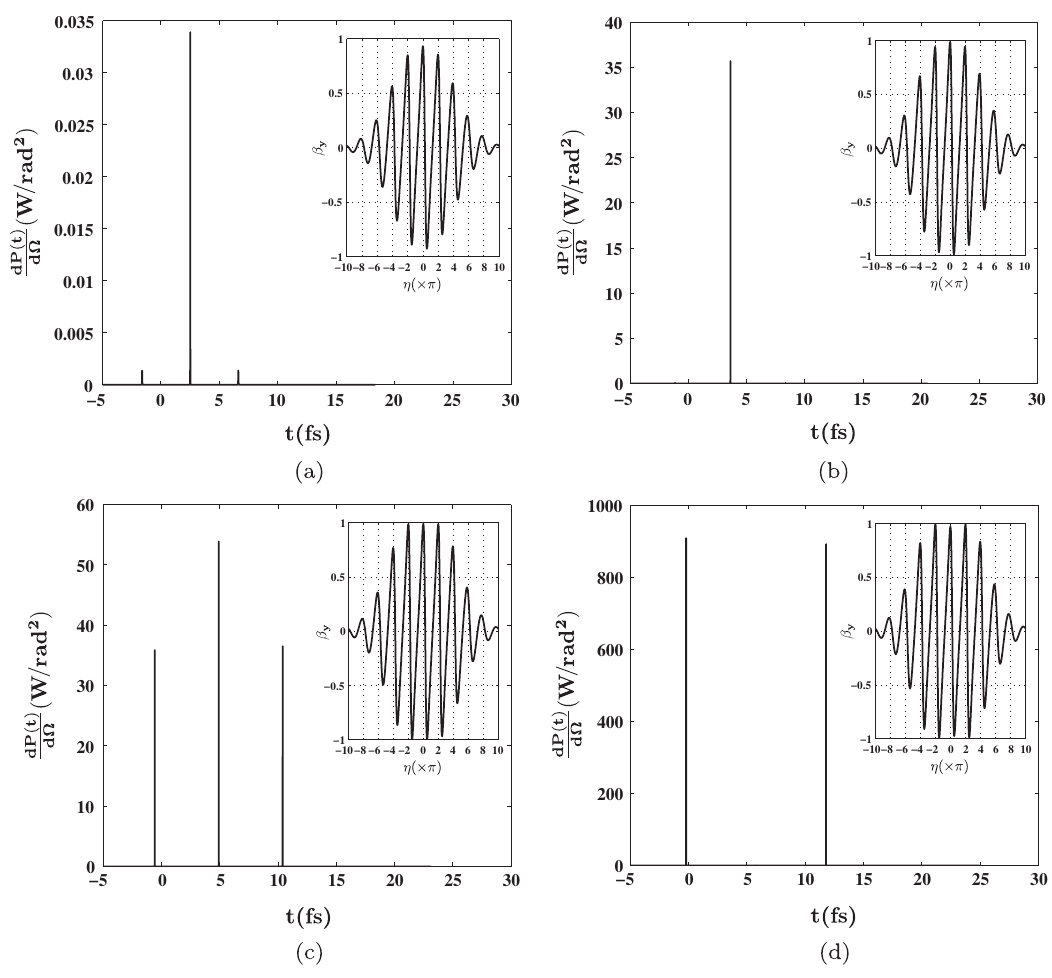
FIG. 8. The time histogram of the radiation power per solid angle along the þ y axis by an electron scattering with a circularly polarized laser pulse. The insets show the normalized velocity (cid:8) y of the electron in the laser field as a function of (cid:1) . (a) a 0 ¼ 15